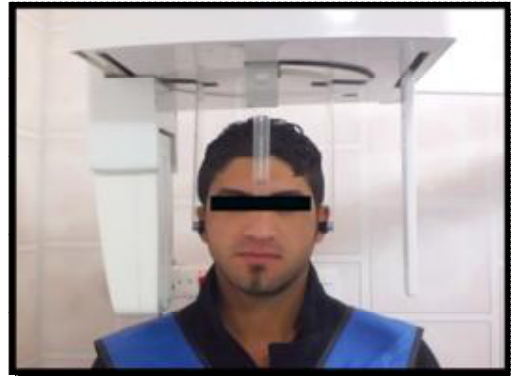
Figure1:Patient Position for Cephalometric Radiography.